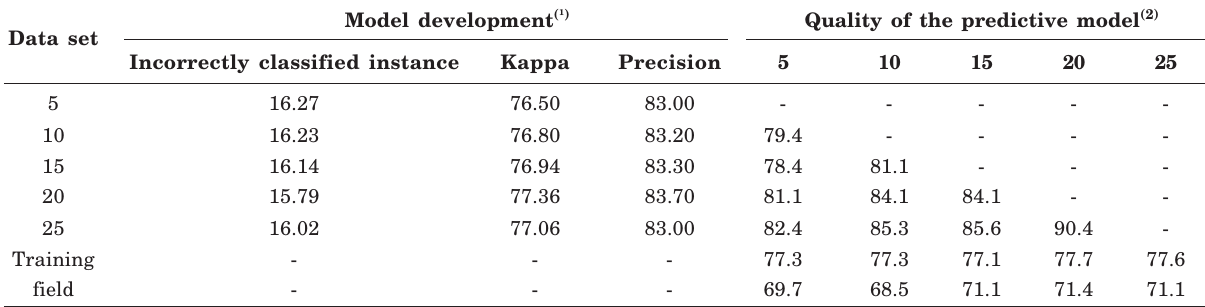
(¹) Output information of the WEKA program after testing the five models in the independent data set (supplied test set). (²) Kappa index between the maps generated with different sampling densities, the training area and the 350 field samples. All values in percentage.